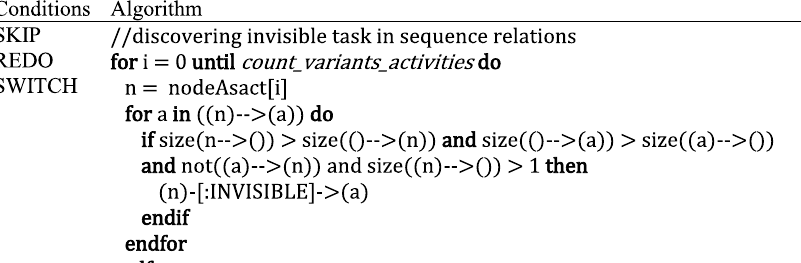
Table 5 The algorithm of GIT for invisible prime task